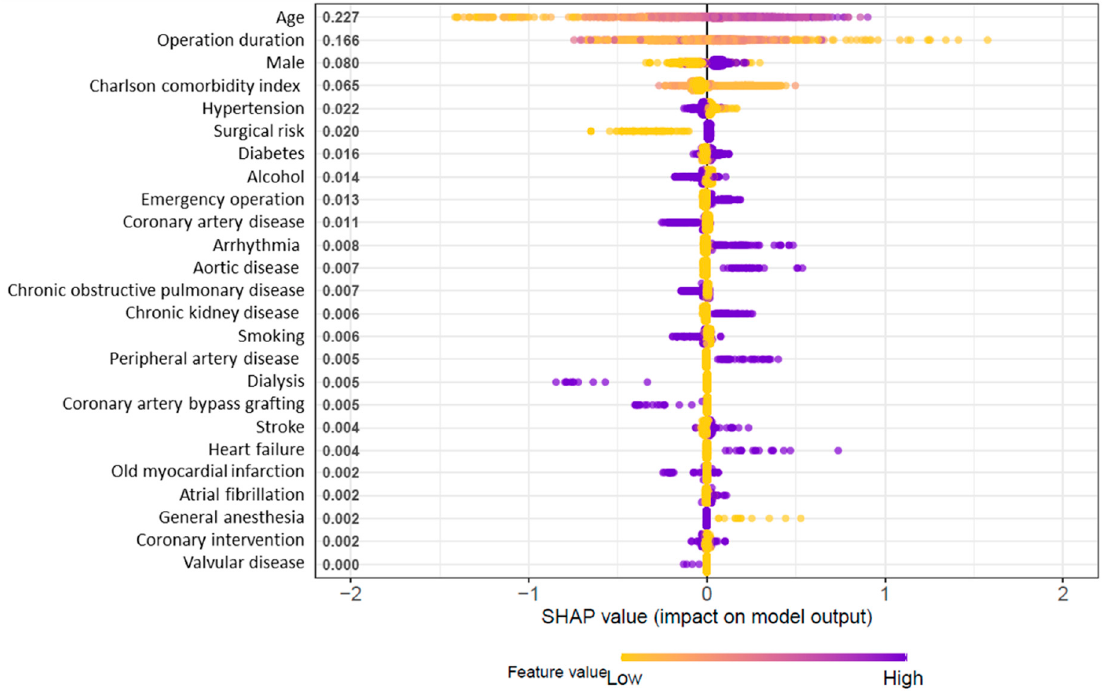
Figure 2. The Shapley additive explanations (SHAP) summary plot representing the results of the extreme gradient boosting (XGB) algorithm of machine learning technique.